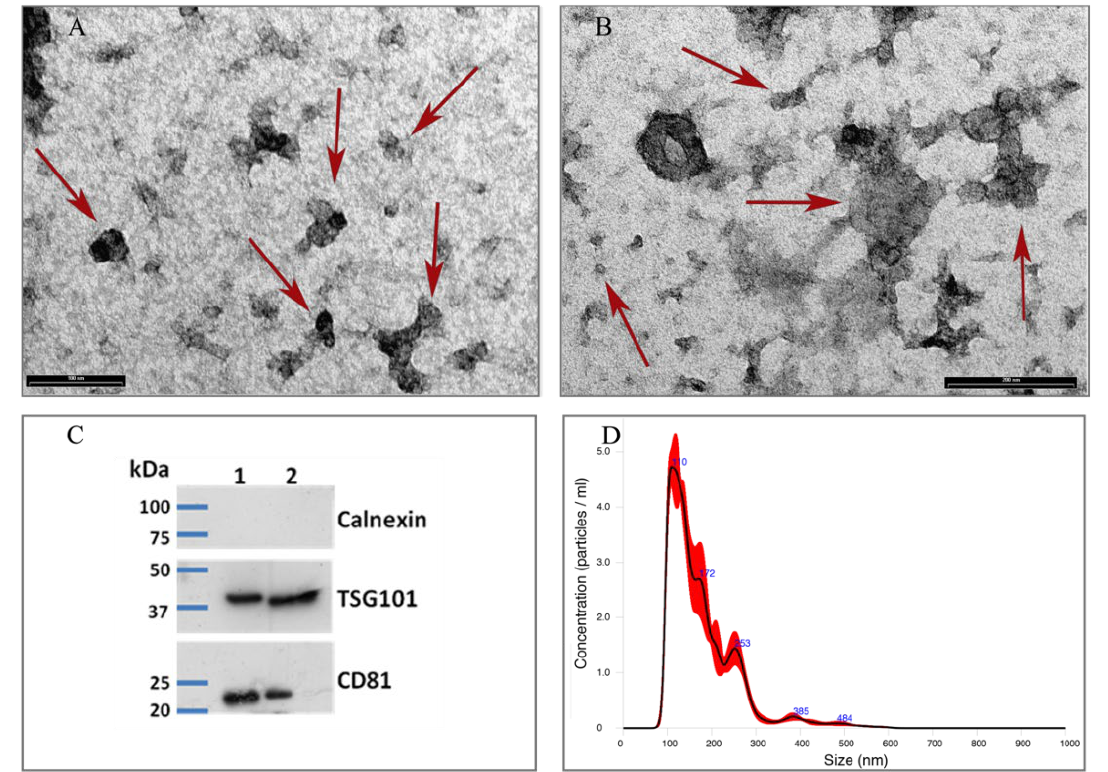
Figure 1. Morphological characterization of isolated colosEVs: Transmission electron microscopy low ( A ) and high ( B ) magnification micrographs showing single and clustered colosEVs indicated by red arrows. Scale bar: A. 100 nm; B. 200 nm; ( C ) Western blot images obtained using Ab against Tsg101 (Tumor Susceptibility Gene 101 protein) and CD81 (Cluster of Differentiation 81) that are both mEV antigens and calnexin as negative cellular debris control of two colosEV samples (1 and 2); ( D ) nanoparticle tracking analysis graph indicating colosEV size